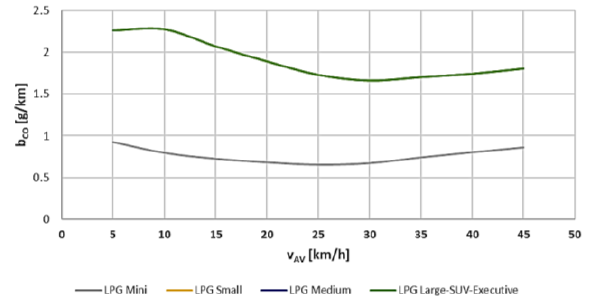
Fig. 35. CO emission from LPG PCs for vehicle segments depending on average speed